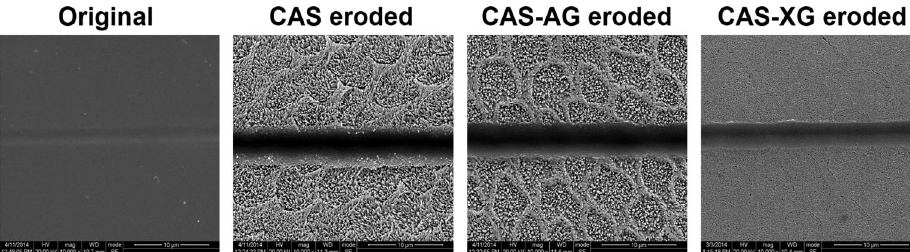
Fig. 7 Typical SEM morphologies of nano-scratches on the enamel surface subjected to different erosion